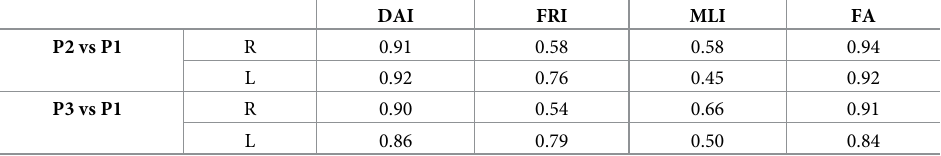
Table 2. Correlation coefficients between foot loading parameters (DAI, FRI, MLI and FA) in the 2 nd vs. 1 st (P2 vs P1) trimester and in the 3 rd vs. 1 st (P3 vs P1) trimester of pregnancy. DAI FRI MLI